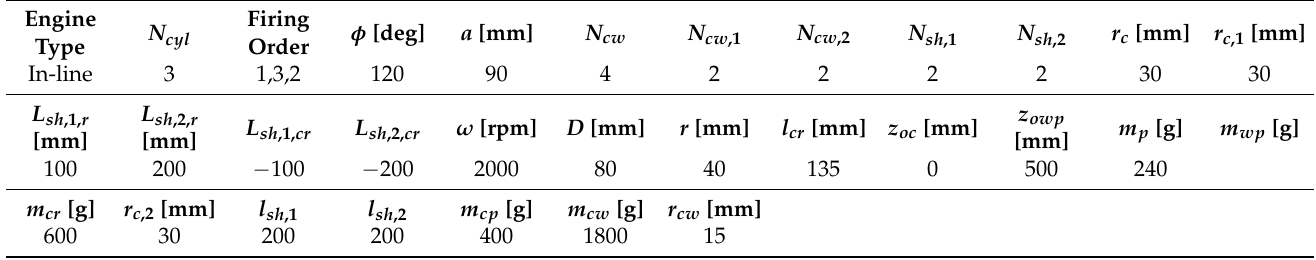
Table 1. Input data for the optimisation of a 3 cylinder in-line engine.